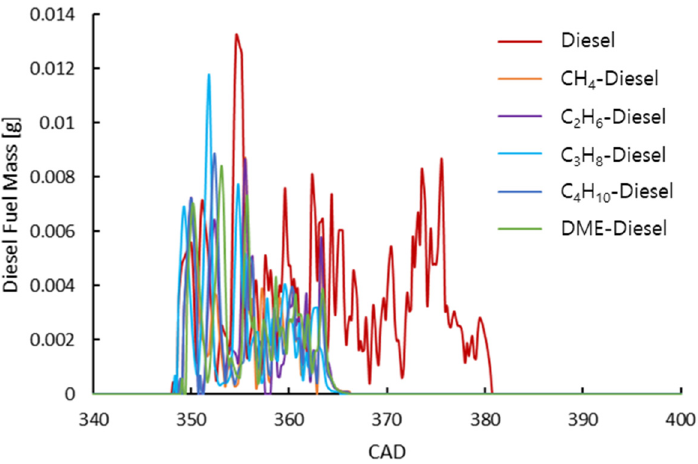
Figure 11. Liquid diesel mass remaining in the engine cylinder